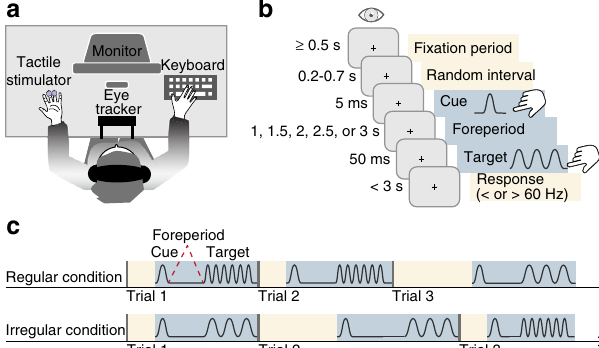
Fig. 1 Setup, procedure, and design. a Setup. Participants sat at a table, their head supported by a chin and forehead rest, and fi xated straight ahead while their eye position was monitored. Tactile stimulators were attached to the nondominant hand; the dominant hand rested on a keyboard. b Trial timeline. Trials began contingent on 0.5 s of continuous fi xation, followed by a variable time interval of 0.2 – 0.7 s, ensuring that the stream of tactile stimuli within any block was nonrhythmic. Tactile cue and target were separated by a foreperiod of 1, 1.5, 2, 2.5, or 3 s. The cue was a single protruding movement of the stimulator tip; the target stimulus was a 50-ms-long vibration. Participants indicated by button press whether they perceived the target frequency as faster or slower than 60 Hz. c Design. We manipulated the degree of temporal predictability by either keeping the foreperiod (cue – target interval, blue ribbons) constant — regular condition — or variable — irregular condition — within